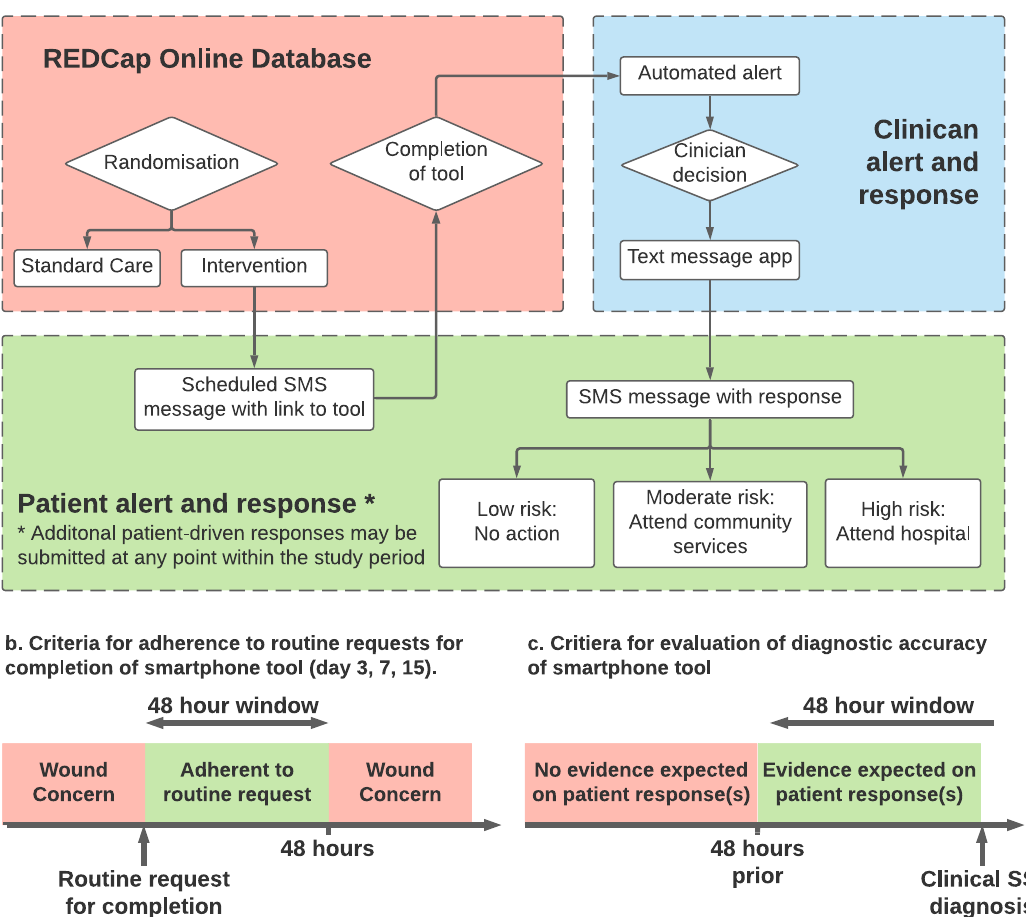
Fig. 5 TWIST Trial de fi nitions and processes. a The intervention schemata which demonstrates the process of the digital health intervention. This outlines how the clinical team was alerted whenever a patient response was submitted (whether patient-initiated or a routine request on days 3, 7, of 15), and the communication to patients when a clinical decision on the risk of surgical-site infection was made. This also depicts the criteria for assessing secondary outcomes in the smartphone arm: b how adherence to routine requests for completion of smartphone tool was determined, and c how diagnostic accuracy of clinical assessments of responses submitted using the smartphone tool was